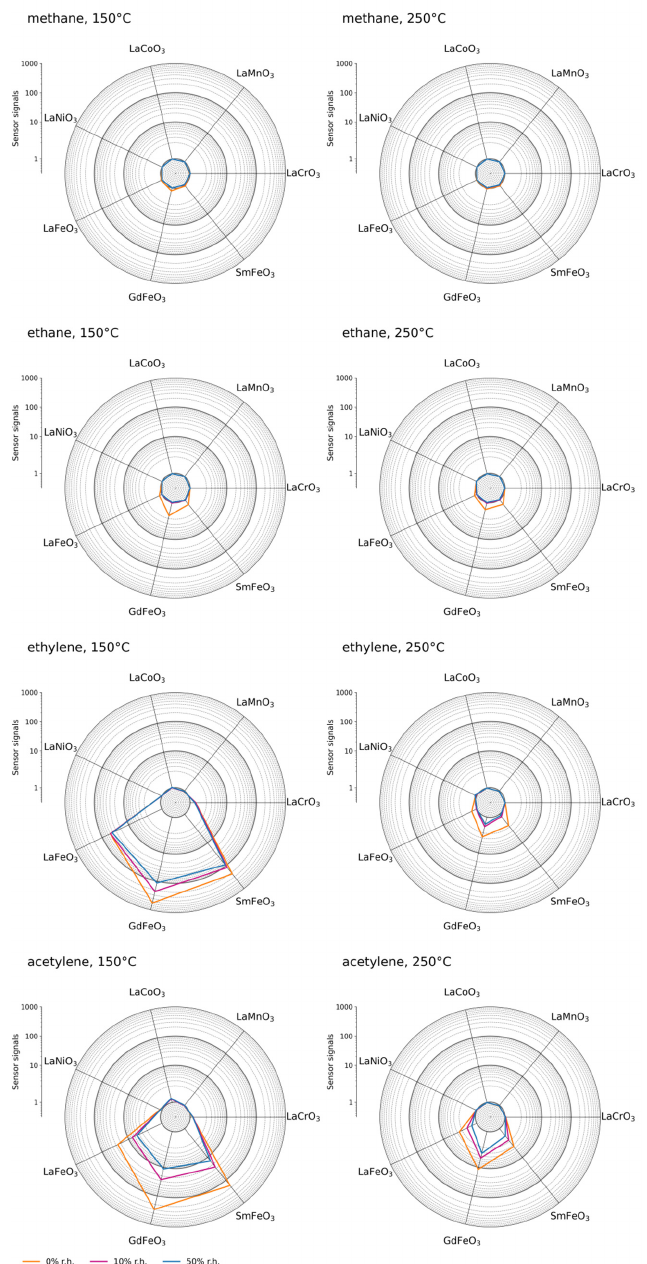
Figure 4. Sensor signals for exposure to 500 ppm of different gases at 150 °C ( left column ) and at 250 °C ( right column ).